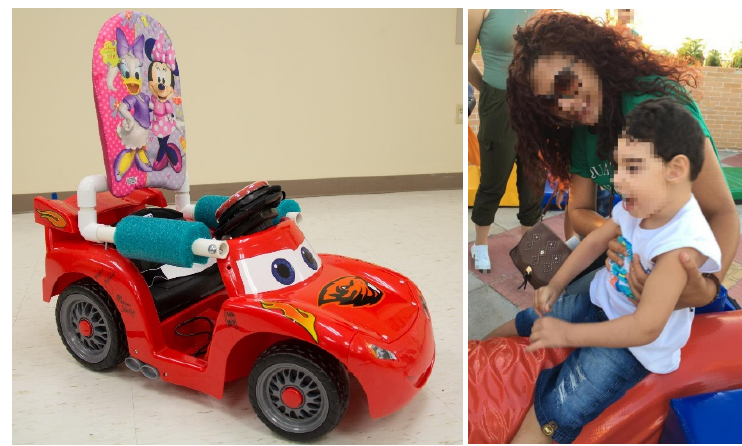
Figure 2. Modified ride-on car and a child with CZS.